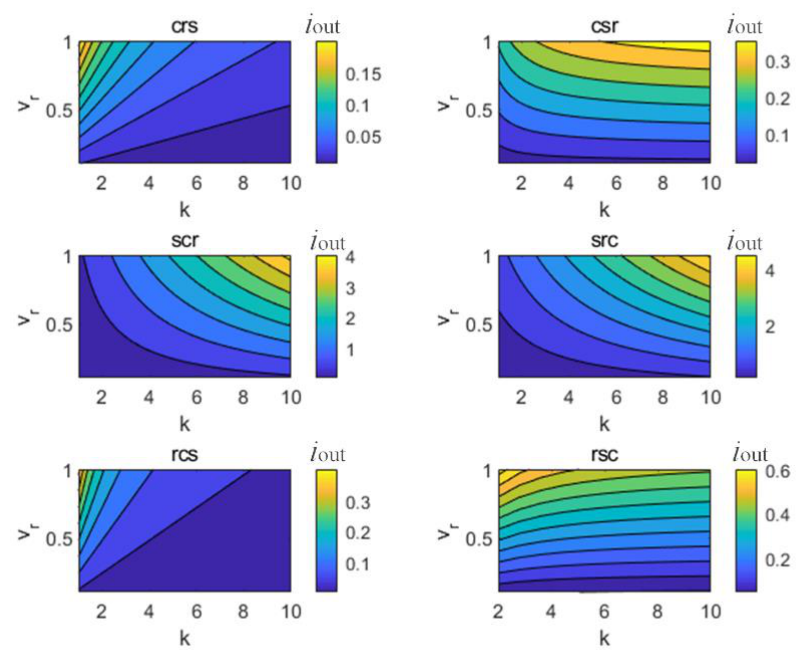
Figure 1. Result distribution graph of i out .